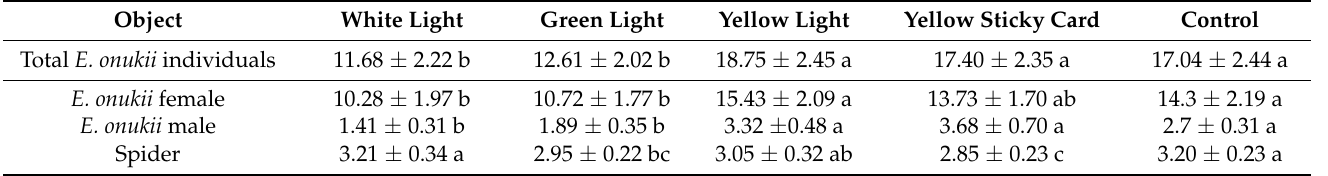
Table 3. Comparison of the daily numbers of tea green leafhoppers and spiders collected during the course of the exclosure experiment. Object White Light Green Light Yellow Light Yellow Sticky Card Control Total E. onukii individuals